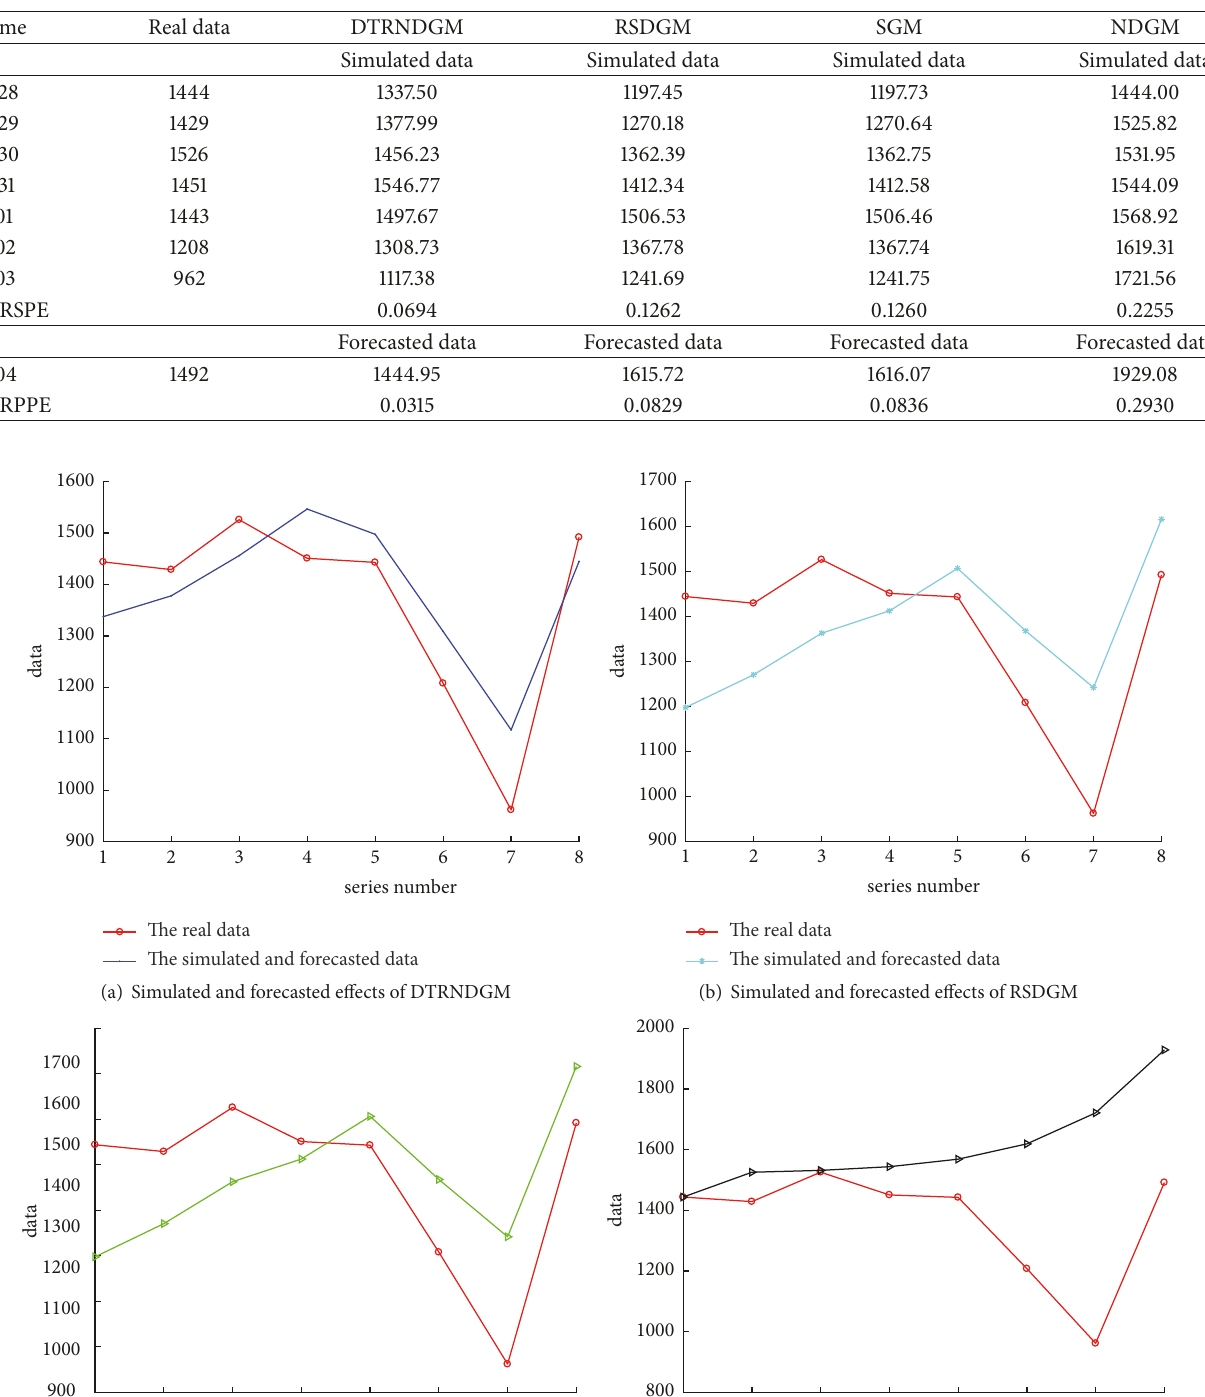
Table 3: Simulated or forecasted values and errors of the traffic flow in the 𝜒 ∈ 𝑅 3×7×24×1 model.